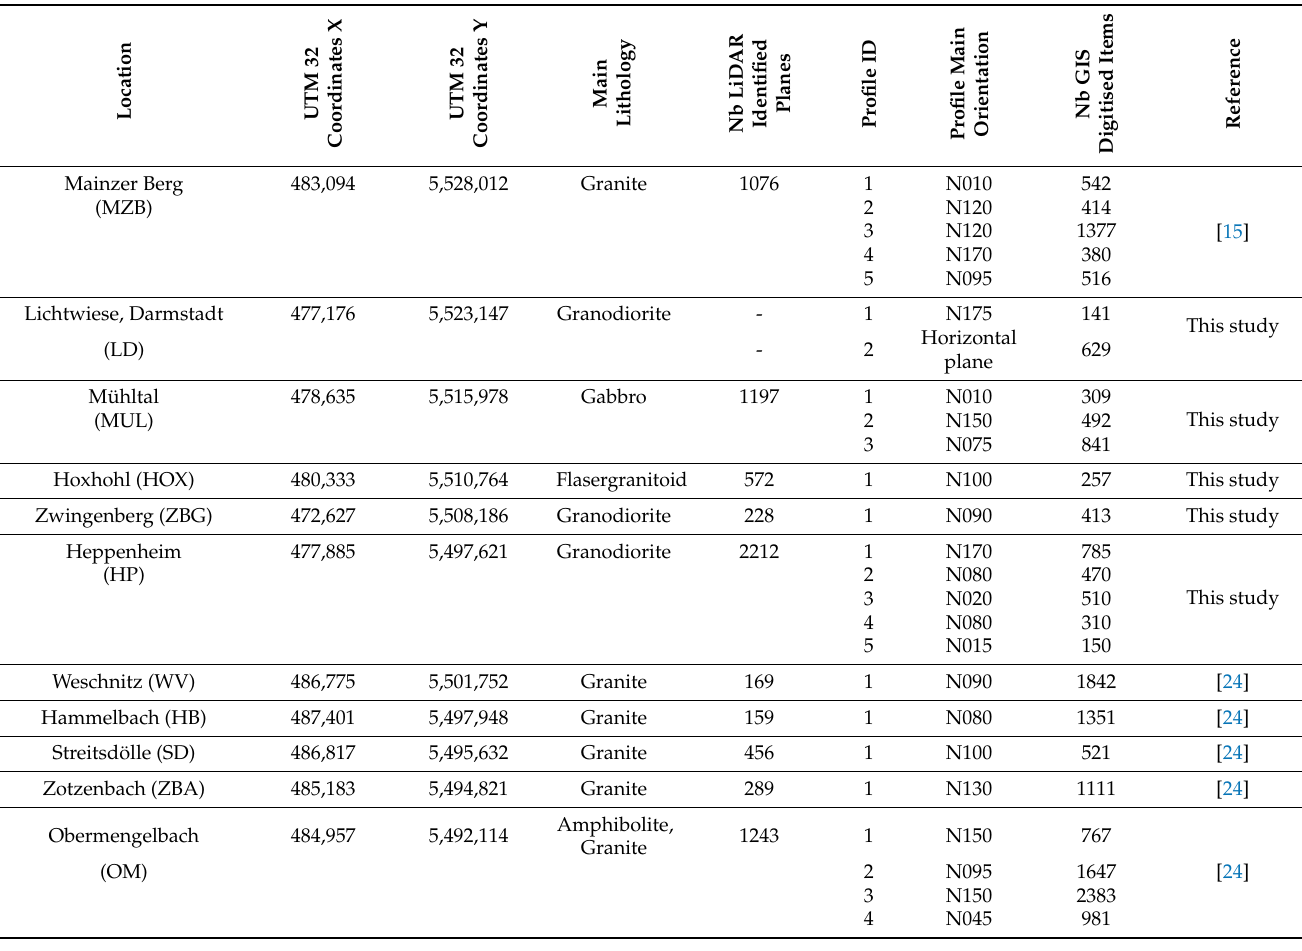
Table 1. Sampling location and profile information, with number of items identified on LiDAR and digitised with GIS.